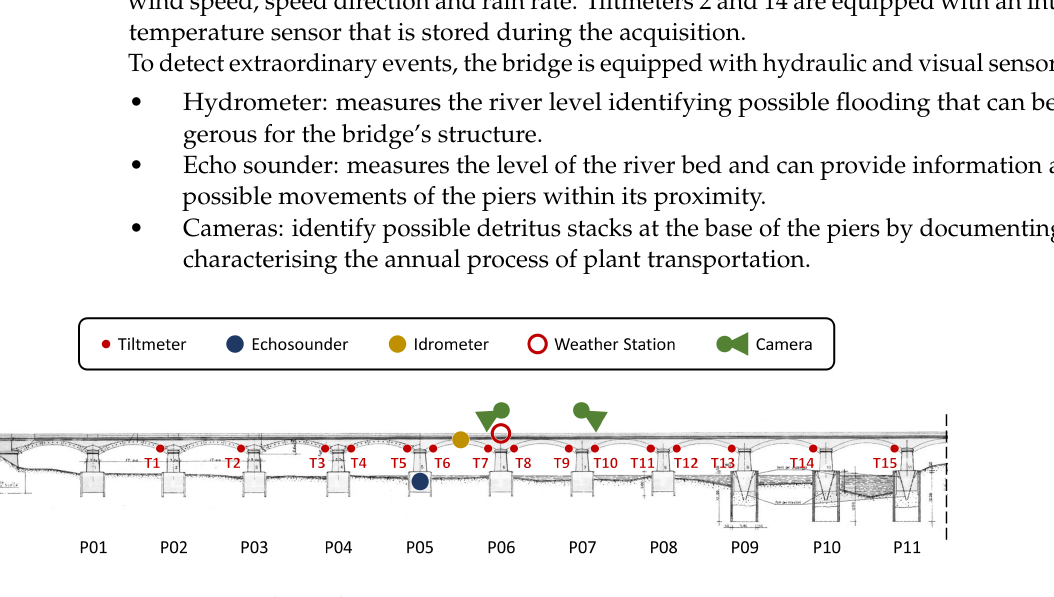
Figure 1. Candia Bridge Monitoring